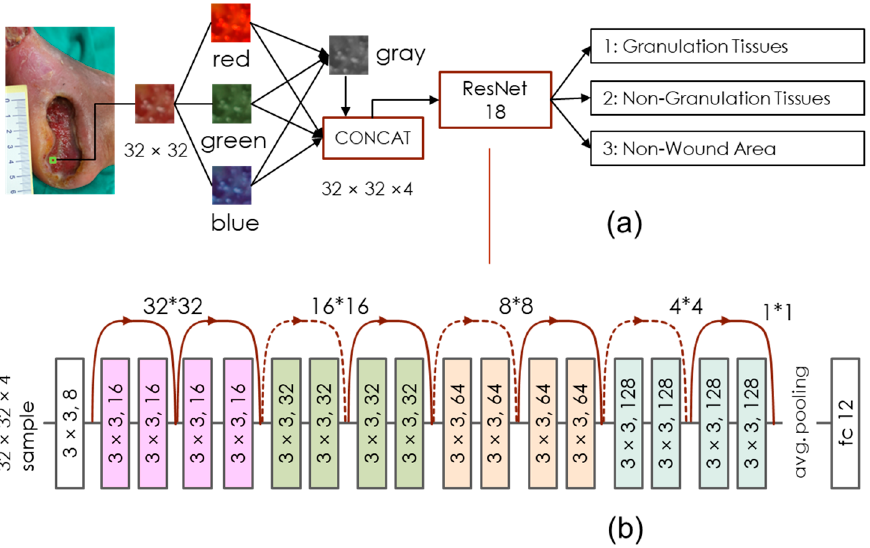
Figure 1. Network architecture. ( a ) This model inspects each 32 × 32 sub-image individually on the wound picture. The detection results in one of three classes: granulation tissues, non-granulation tissues, and non-wound areas. ( b ) The ResNet18 network model we used in this research is reduced to 1/4 of the original size. We can thus save the computing resources and avoid the overfitting problem.